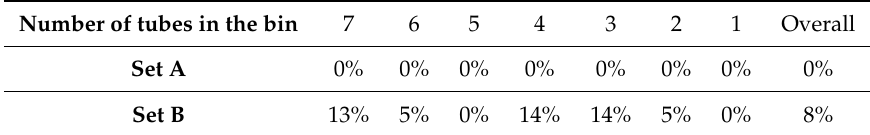
Table 7. Percentages of picking attempts where the entanglement resolution phase was